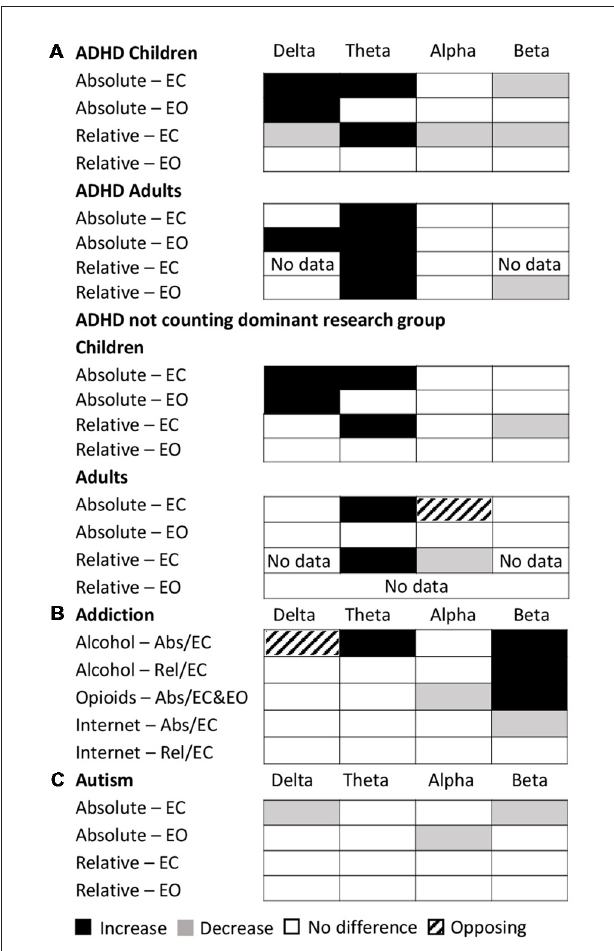
FIGURE 7 | Dominant results across conditions for specific disorders. (A) Dominant result for each band for ADHD for each of various conditions and age groups for both relative (rel) and absolute (abs) power and for eyes closed (EC) and eyes open (EO), including all studies (top) and excluding the dominant research group (bottom). White boxes indicate no change, black indicates an increase, and gray indicates a decrease. Opposing results are shown by hashed boxes. (B) Dominant result for each band for each type of addiction and condition. Legend as in (A) . (C) Dominant result for each band for autism for each condition. Legend as in (A)